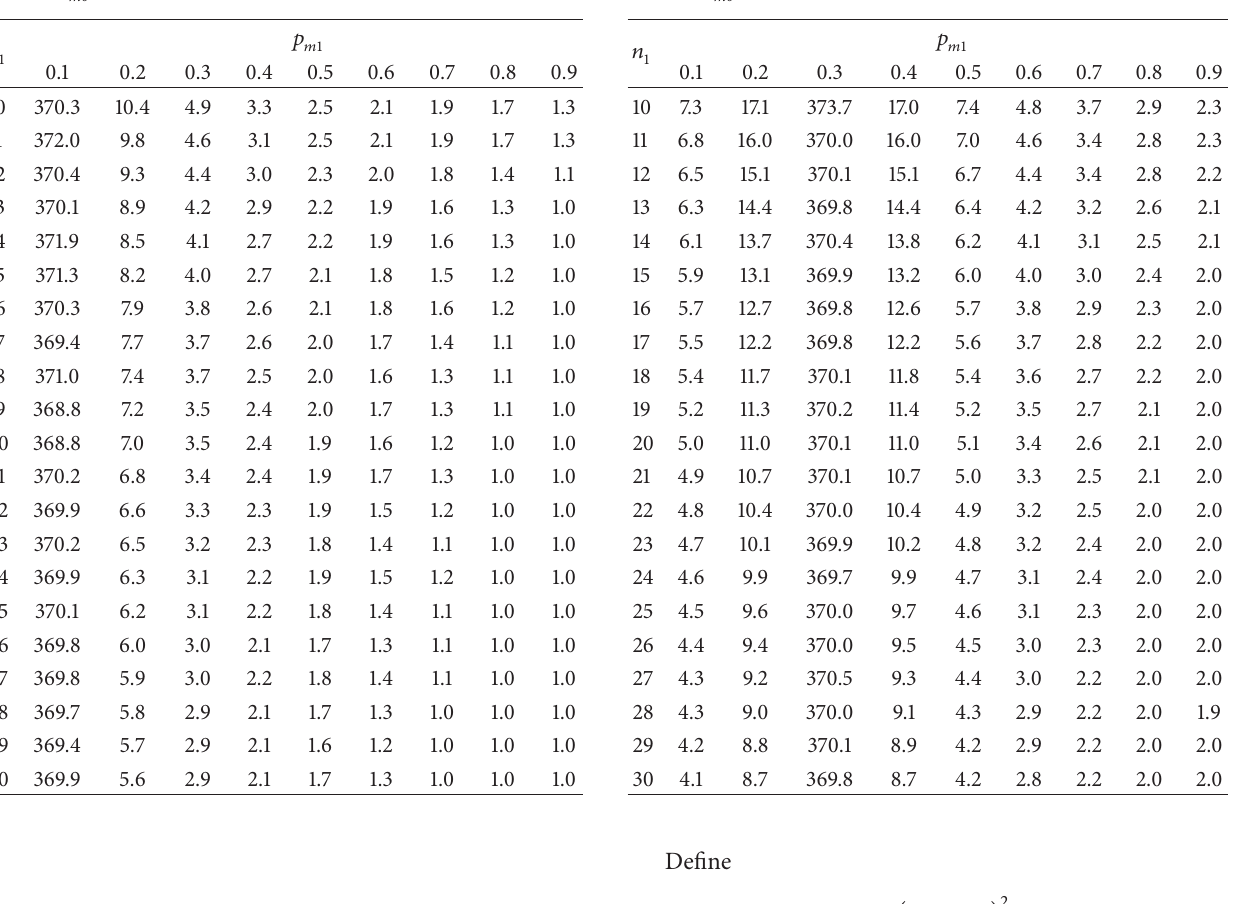
Table 2: The ARL 𝑚1 of the EWMA-AM chart ( 𝜆 1 = 0.05 , 𝑝 𝑚0 = 0.1 with ARL 𝑚0 ≈ 370 ).